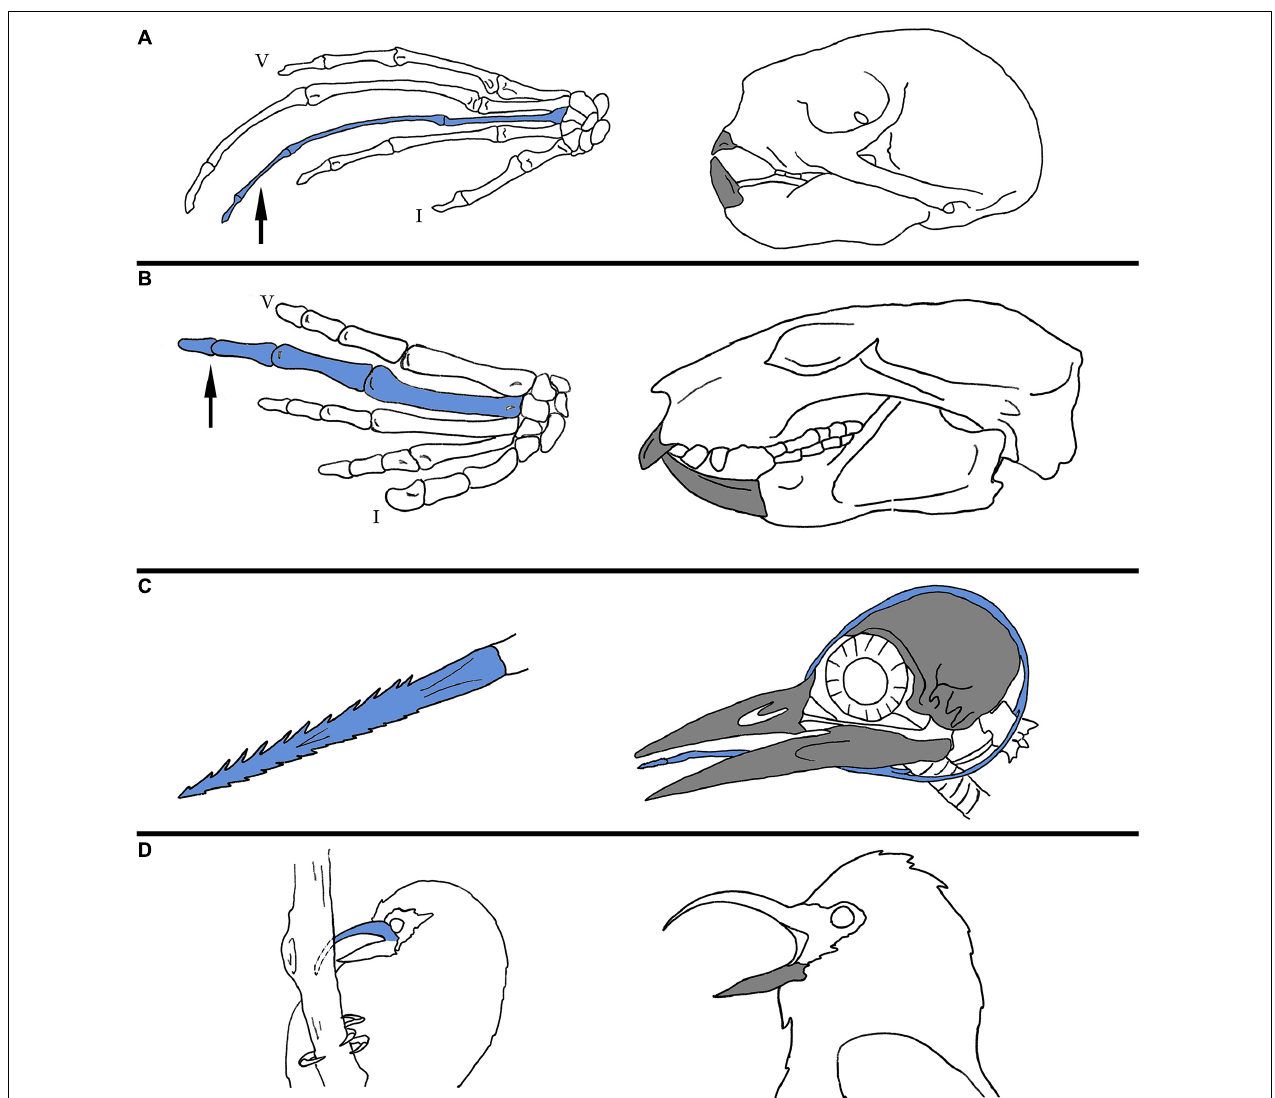
FIGURE 2 | In all known extant taxa that bore into and probe within hard substrate (e.g., wood), the “tool” used to extract prey items are accompanied by a structure that first allows entry into the hard substrate. The left column exhibits the morphologies used to probe and extract prey items (shaded blue), while the right column shows the morphologies used to break into the hard substrate (shaded gray). (A) The Aye-aye ( Daubentonia madagascariensis ) and the (B) Striped Possum ( Dactylopsila trivirgata ) both exhibit elongate manual digits used to probe in holes made in wood created by specialized rostromedially angled incisors which gnaw away woody material. The arrows indicate the specific digit used to probe. (C) Insectivorous woodpecker species exhibit distally barbed tips of the tongue covered in thick sheaths in order to skewer prey items within cavities which are accessed by gouging made possible by a robust conical bill and cushioned cranium. (D) The “Akiapola”au ( Hemignathus munroi ) probes with its distally tapered flexible upper bill, while the bottom robust bill, reminiscent to that of most woodpeckers, facilitates wood gouging with its straight, wedge-like shape. Line illustrations not drawn to